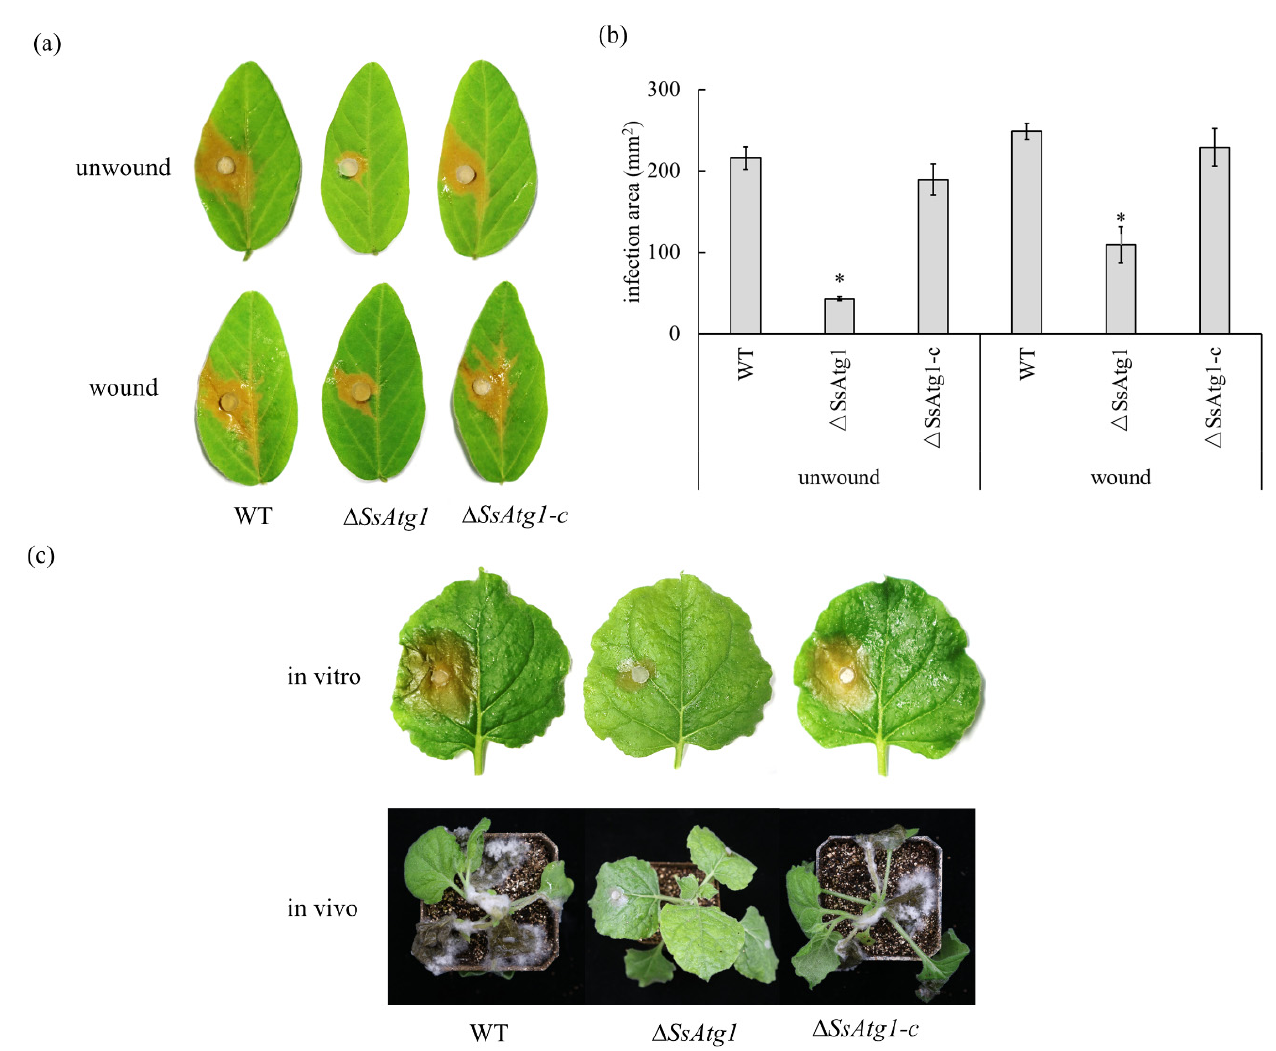
Figure 6. SsAtg1 affects the virulence of S. sclerotiorum . ( a ) Pathogenicity of ∆ SsAtg1 on soybean leaves. ( b ) Quantification of the infection area. Image J was used to measure the infection area. ( c ) Pathogenicity of ∆ SsAtg1 on tobacco. Error bars represent the standard deviations and the asterisk indicated significant differences (p < 0.05).